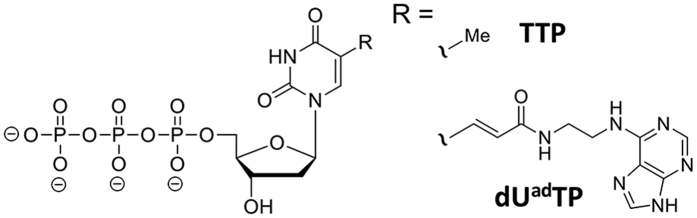
Chemical structures of natural TTP and dUadTP.